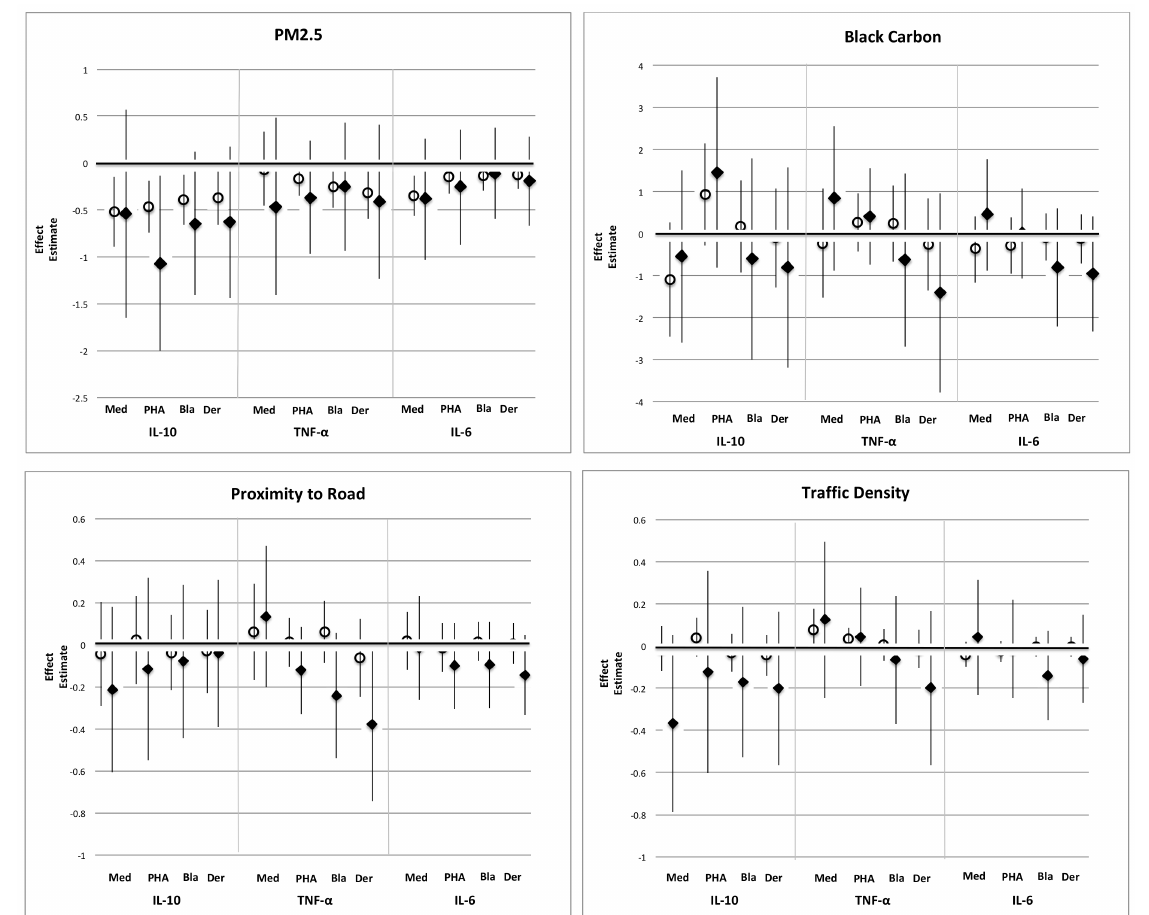
Figure 2. Effect estimates * for the association of air pollution and cytokine concentrations (in unstimulated (Med) cord blood lymphocytes or for those stimulated with phytohemagglutinin (PHA), cockroach antigen (Bla), or dust mite antigen (Der)), in ever and never depressed women. Open circles: never-depressed mothers. Closed diamonds: ever-depressed mothers. Unstimulated IL-10 was analyzed using Tobit regression; TNF- α and IL-6 were analyzed using linear regression. Outcomes were log-transformed for analysis. Models were adjusted for maternal age, race/ethnicity, education, household income, child sex, the season of birth, pre-pregnancy BMI, and smoking. * For PM 2.5 and BC, (effect estimate × 100) is approximately the % change in cytokine concentration for a 1-unit increase in air pollution. For proximity to road and traffic density, the effect estimate is the % change in cytokine concentration for a 1% increase in air